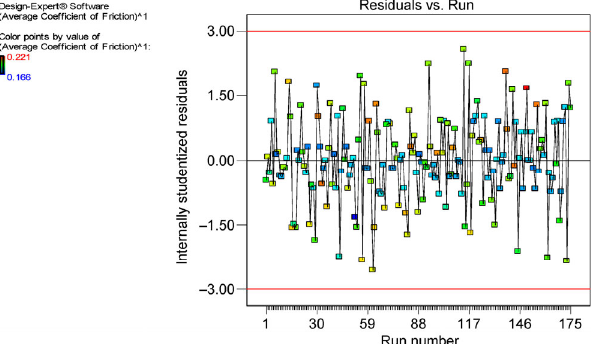
Fig. 11 Distribution of residuals over the experimentation run order for the average coefficient of